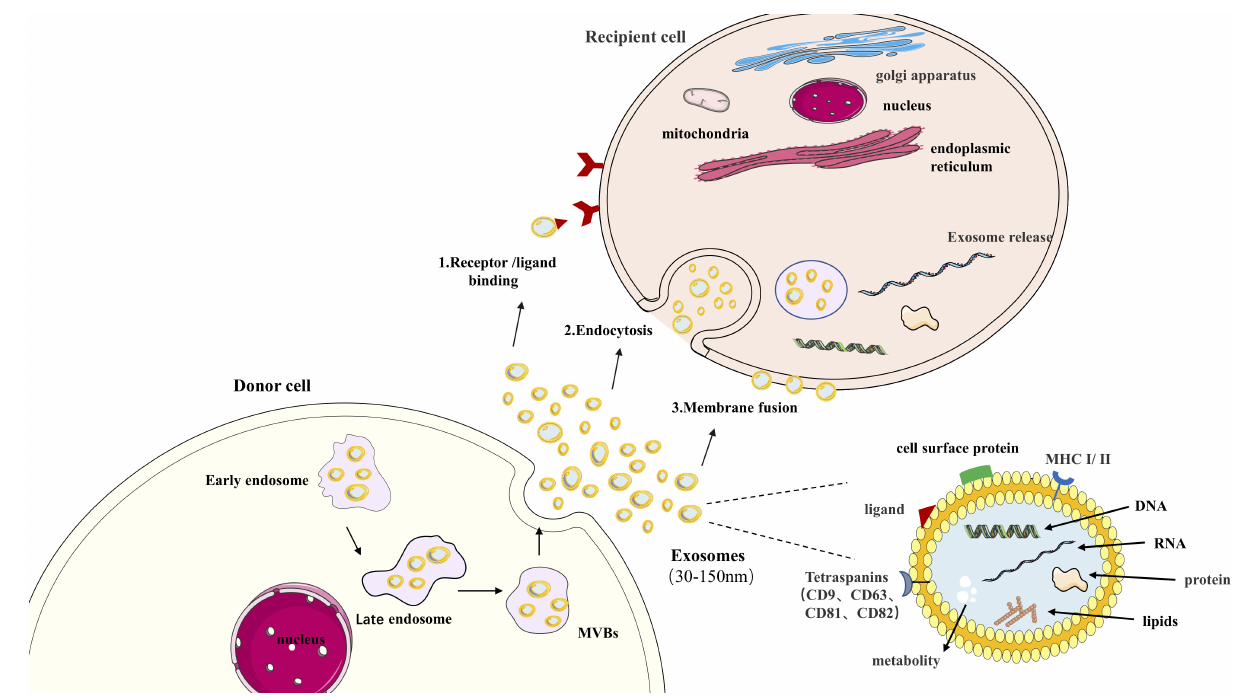
FIGURE 1 | Exosome in cell communication. Exosomes are nanovesicles (30–150nm) that originate formed by early endosomes, late endosomes, and ultimately multivesicular bodies (MVB). Exosomes contain a variety of proteins, lipids, DNA, RNA, and metabolites. The cell body’s surface includes major histocompatibility complex (MHC I/II), Tetraspanins (CD9, CD63, CD81, CD82), cell surface proteins ligand. This confers them with functional features. Exosomes can transmit information to target cells by: (1) binding to the cell surface by ligand, (2) endocytosis, (3) direct fusion of extracellular with plasma membranes.